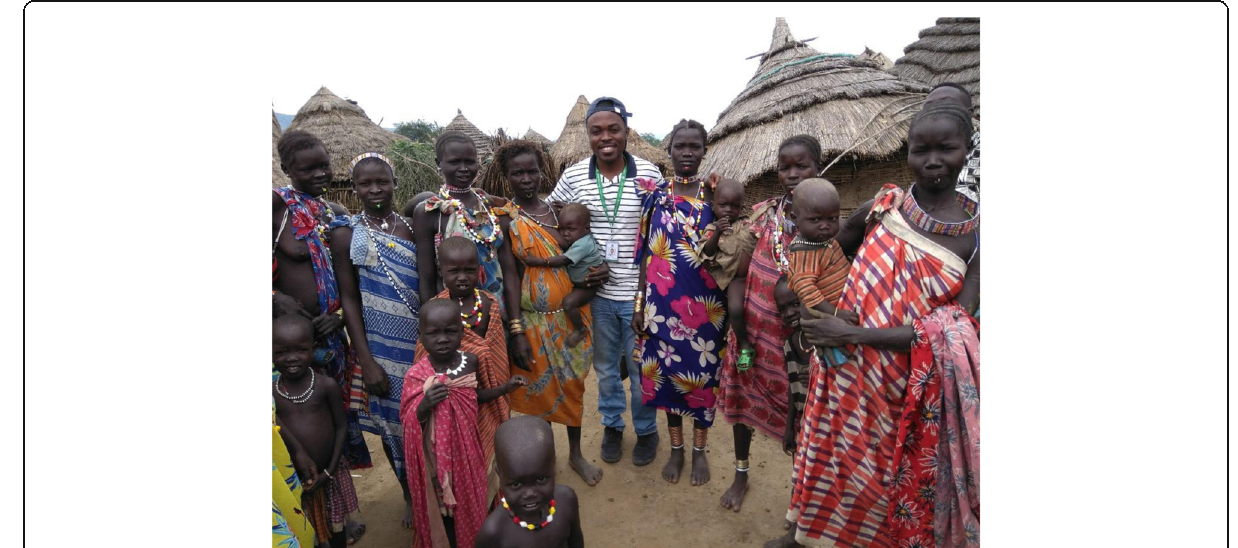
Figure 2 Field visit to Toposa women during evaluation data